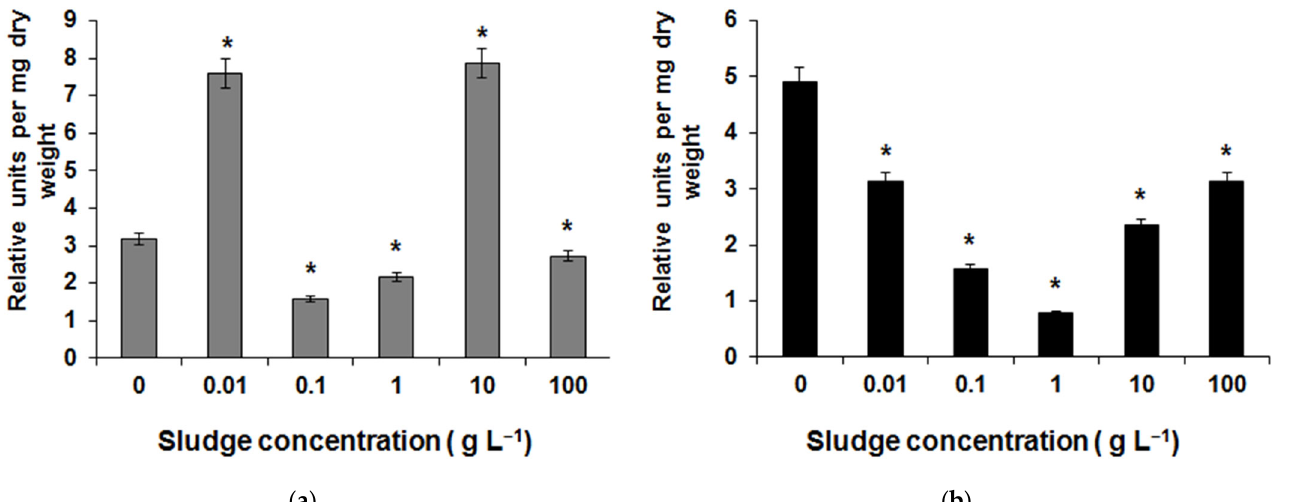
Figure 8. The activity of enzymes of the antioxidant system: ( a ) Catalase; ( b ) Peroxidase. *—significant differences with the control.